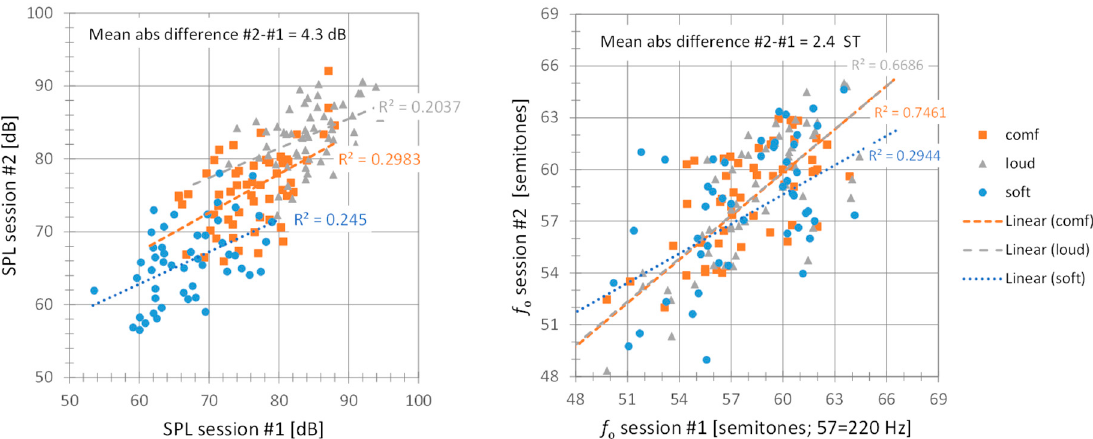
Figure 4. Correlation plots of sustained vowel /a/ productions pre- and post-intervention ( N = 58) for the same elicitations; ( left panel ) SPL, ( right panel ) f o , both averaged over the central part of the vowel. Each participant is represented by three markers ■ ▲ ● .